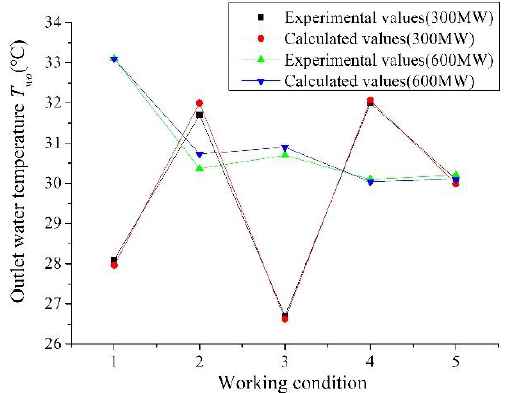
Figure 6. Calculated and experimental values of outlet water temperature at five working conditions.